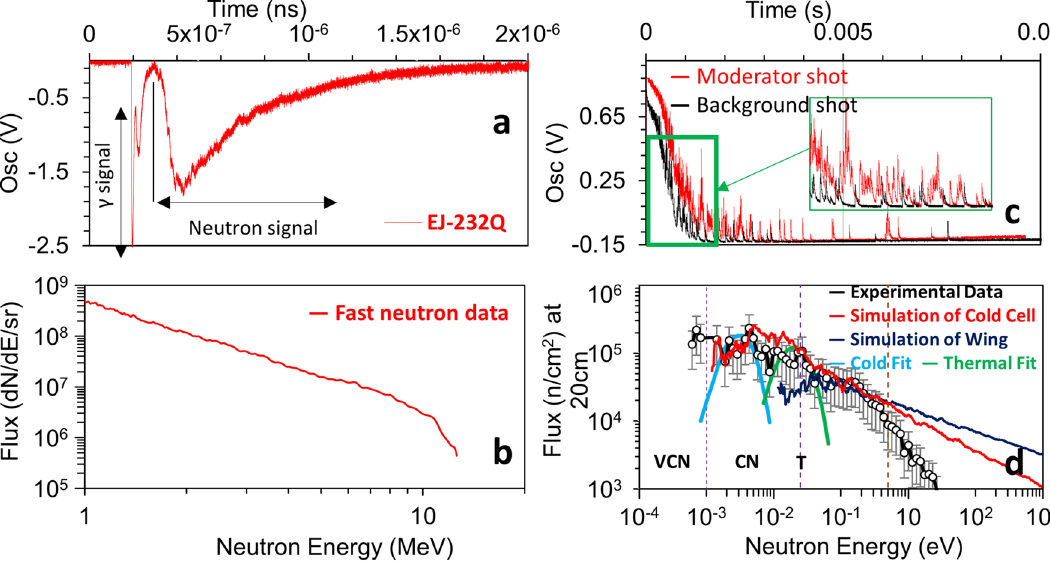
Figure 4. Experimental results. ( a ) is the raw signal recorded using EJ-232Q plastic scintillator and the corresponding spectrum shown in ( b ), which was calculated by taking into account the detector distance, efficiency and the transmission. ( c ) demonstrating the neutron spikes generated by nuclear reaction of 3He(n,p)3H3He(n,p)3H in the proportional counter for a typical moderator shot (with hydrogen) and no moderator shot (without hydrogen). The background-subtracted data at 20 cm exit surface of the moderator showing a good agreement with the Monte-Carlo simulation results as shown in ( d ). The broadened peak of neutrons extended its tail reaching 0.8 meV and has been confirmed using two Maxwellian numerically calculated fits for the cold and thermal temperature. The navy blue line is showing the contribution of the wing moderator which is barely reaching the thermal